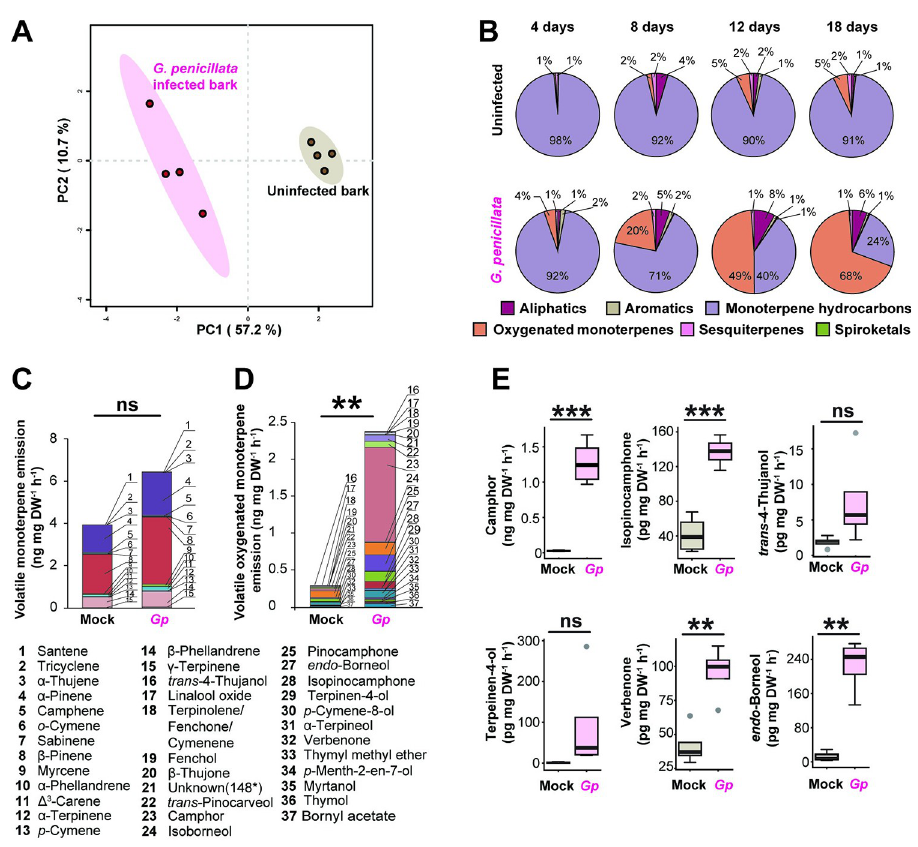
Fig 2. Growth of Ips typographus symbiotic fungi on spruce bark induces increased emission of oxygenated monoterpenes. (A) Volatile emission pattern differed between spruce bark inoculated with G . penicillata ( Gp ) and uninfected bark 4 days after inoculation, as depicted in a partial least squares discriminant analysis (PLS-DA). Complete volatile emission data by compound for G . penicillata and other I . typographus fungal symbionts are given in S2 Table. (B) Changes in volatile emission profiles of spruce bark due to G . penicillata infection over an 18-d time course. Compounds are classified into six groups by their chemical structures ( n = 3 to 5). Each circle displays the relative amounts of each class of compounds at a single time point and does not indicate changes in the total amounts of volatiles. Complete volatile emission data by compound and time point for G . penicillata and other symbionts are given in S3–S6 Tables. ( C , D ) Emission of specific monoterpenes from fresh spruce bark inoculated with G . penicillata at 4 days post-inoculation. Identified compounds were classified into monoterpene hydrocarbons (C) and oxygenated monoterpenes (D). The individual compounds are stacked within a single bar representing the total emission. Significant differences in the total emission levels induced by G . penicillata are denoted by asterisks above the bars ( n = 4, Welch’s t test with ns = not significant � P < 0.05, �� P < 0.01, ��� P < 0.001). The numbers denote the identities of the compounds in the stacked bars. Complete volatile emission data are given in S2 Table . (E) Emission rate of major oxygenated monoterpenes from spruce bark inoculated with G . penicillata 4 d post-inoculation. Asterisks indicate significant differences between the spruce bark-inoculated G . penicillata and the fungus-free control (Welch’s t test). The data underlying this Figure can be found at